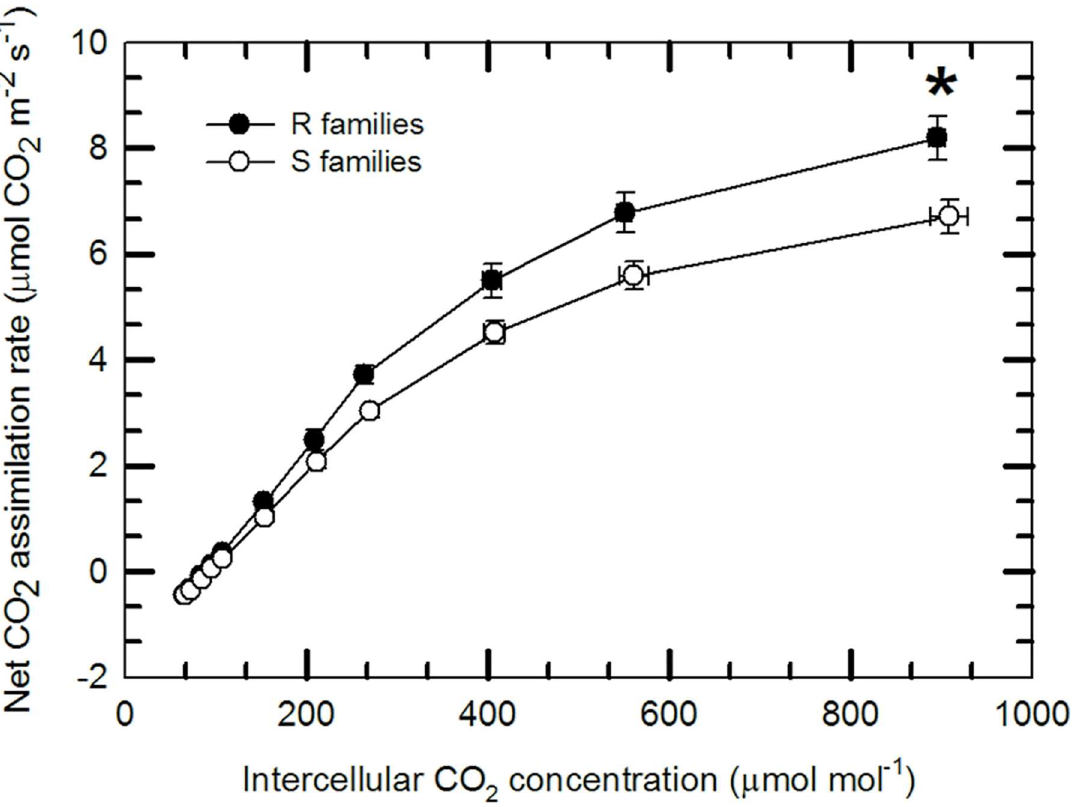
Fig 1. Responseof net CO 2 assimilationrate to intercellular CO 2 concentration for R and S familiesof limberpine. Curveswere taken at a leaf temperatureof 25°C, PPFD of 1,800 μ mol photonsm -2 s -1 and leaf-to-air vapor pressure difference of 1.6 kPa; net CO 2 assimilationrate is expressed on a totalleaf surface area basis. Statistically significant differences are denotedby an * for P <